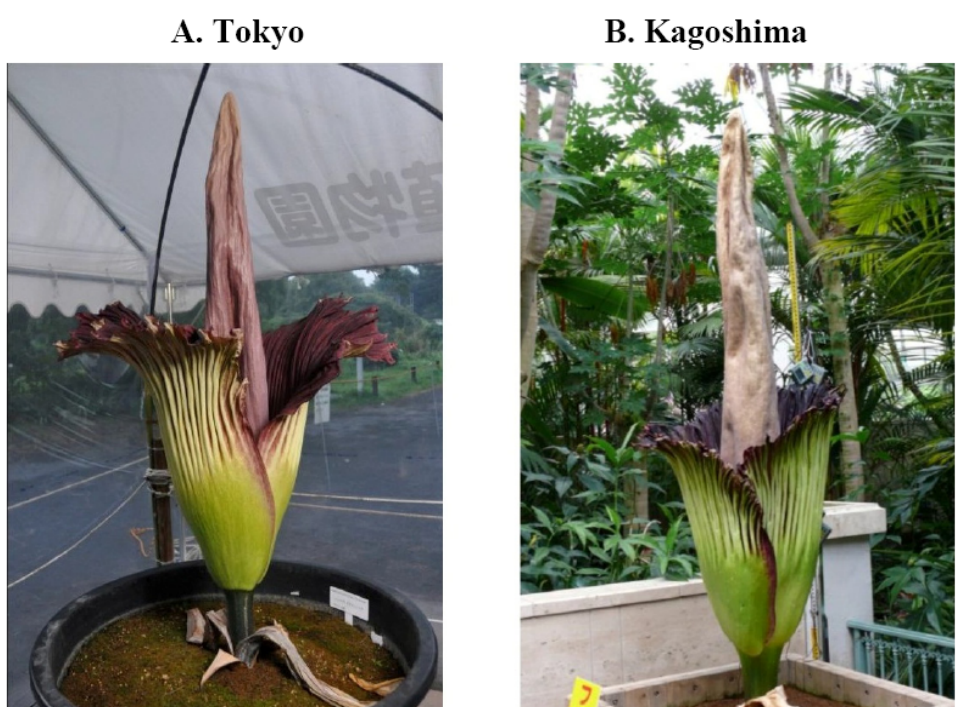
Figure 1. Titan arum grown in Tokyo ( A ) and Kagoshima ( B ), two locations in Japan those are approximately 1,000 km